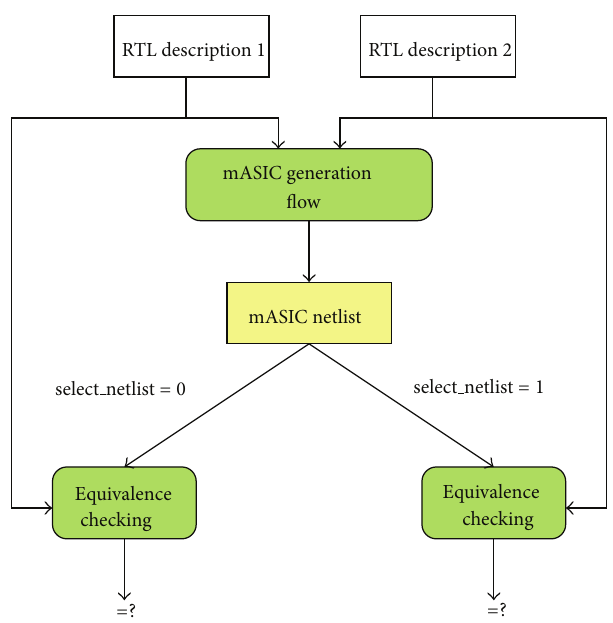
Figure 15: Equivalence checking flow for mASIC.